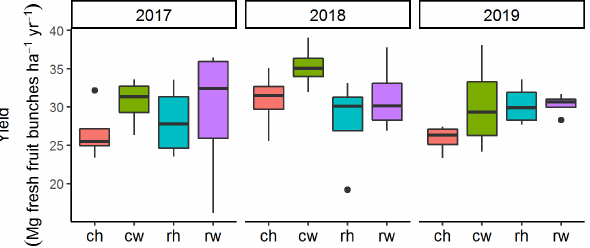
Figure A2. Annual yield of each experimental treatment from 2017 to 2019. Treatments: ch is conventional fertilization–herbicide, cw is conventional fertilization–mechanical weeding, rh is reduced fertilization–herbicide, and rw is reduced fertilization–mechanical weeding. Note that yield was measured by weighing the harvested fresh fruit bunches from each palm in the inner 30m × 30m area of each